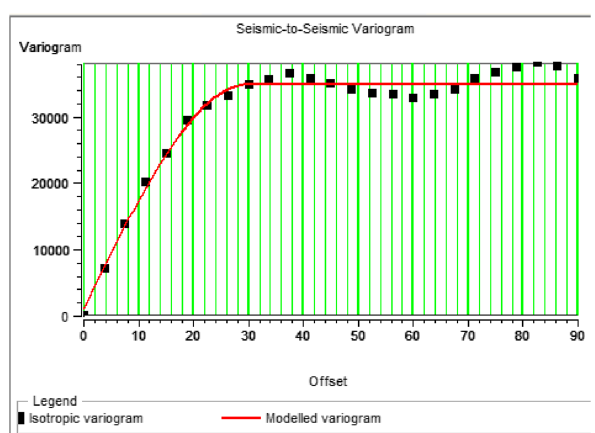
Fig. 27 Spatial structure of the second seismic